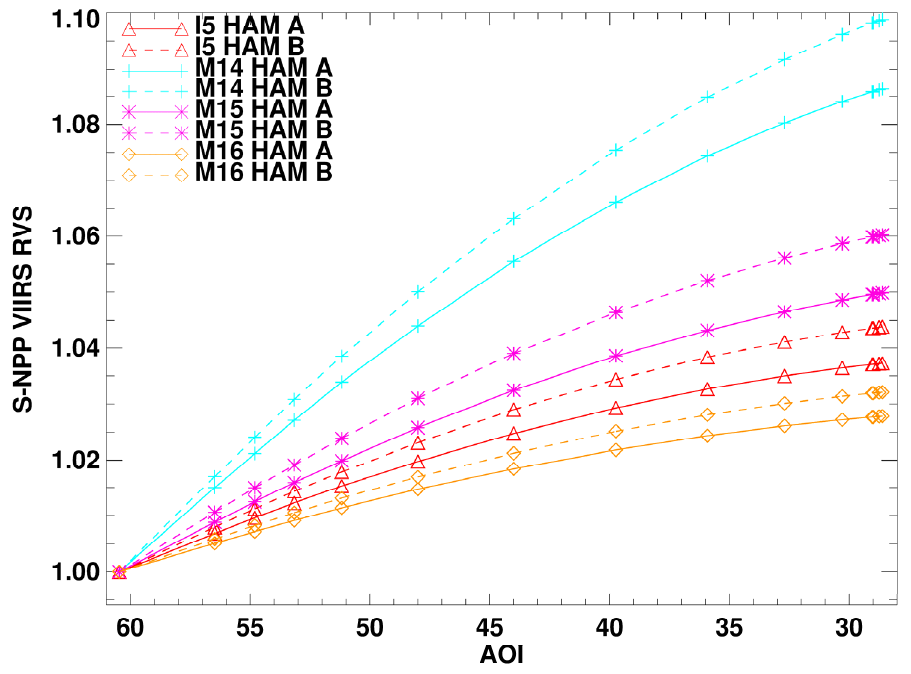
Figure 19. Band-averaged RVS for S-NPP VIIRS all TEBs from the SV AOI through to the end of scan AOI for the LWIR bands.